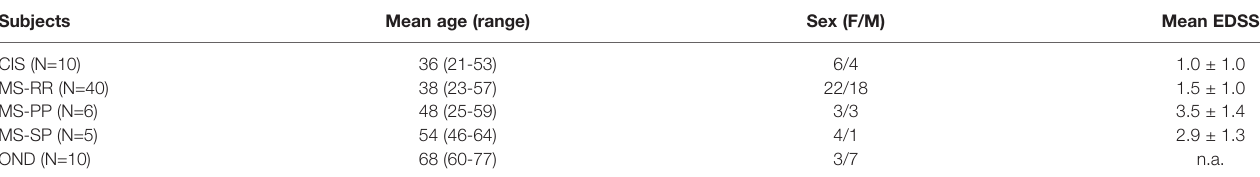
TABLE 1 | Demographic and clinic characteristics of MS